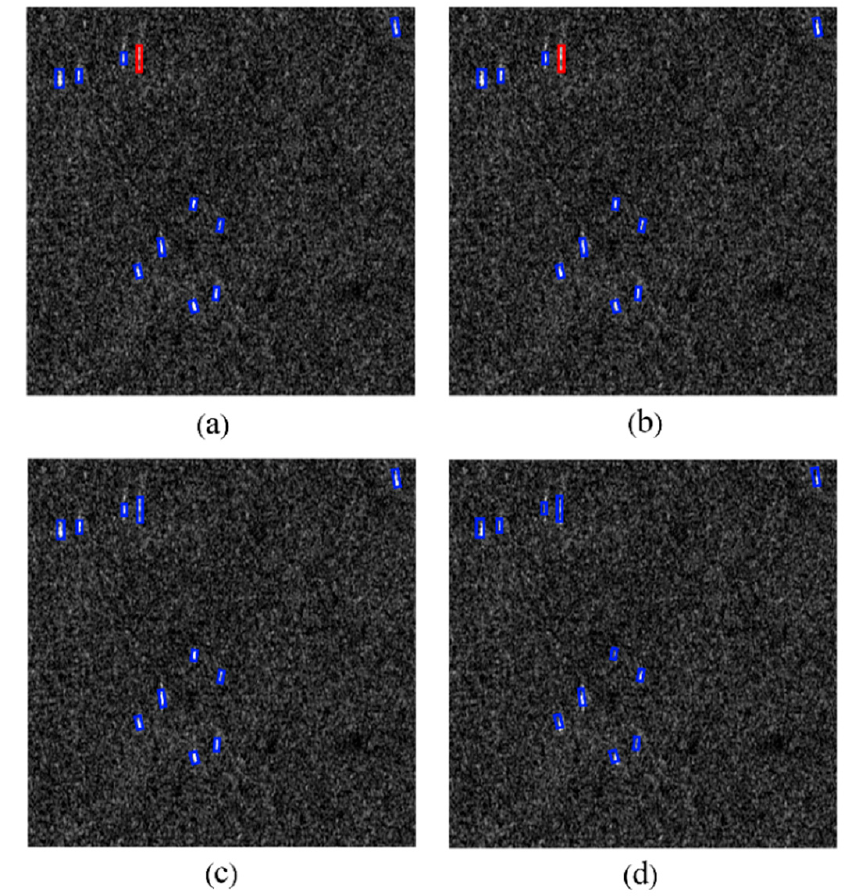
Figure 19. The effect of CBAM. ( a ) The detection result of the experiment setting of NO CBAM and